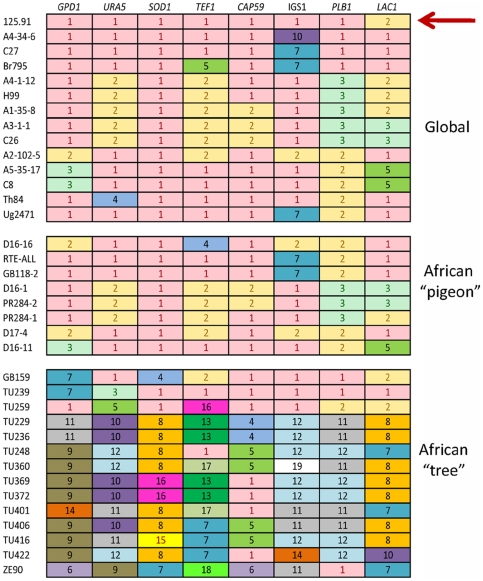
Comparison of representative allelic profiles of isolates of C. neoformans var. grubii from (top panel) the global population (VNI), including seven clinical and seven pigeon isolates, (middle panel) the coprophilic African population associated with pigeons (VNI), and (bottom panel) the African population associated with trees (VNB and VNI).Strain designations (see Table S2) are listed on the left. Under each locus, identical haplotypes are denoted with the same number and color. Haplotypes that are associated with both pigeons and trees are shown in pink (# 1) and yellow (# 2), respectively, and they represent ancestral haplotypes of the global population. The ancestral MLST genotype that might have emerged from Africa is marked with a red arrow. Emergence of any two strains comprised only of pink and yellow progenitor haplotypes can explain diversity in the contemporary global population of VNI.